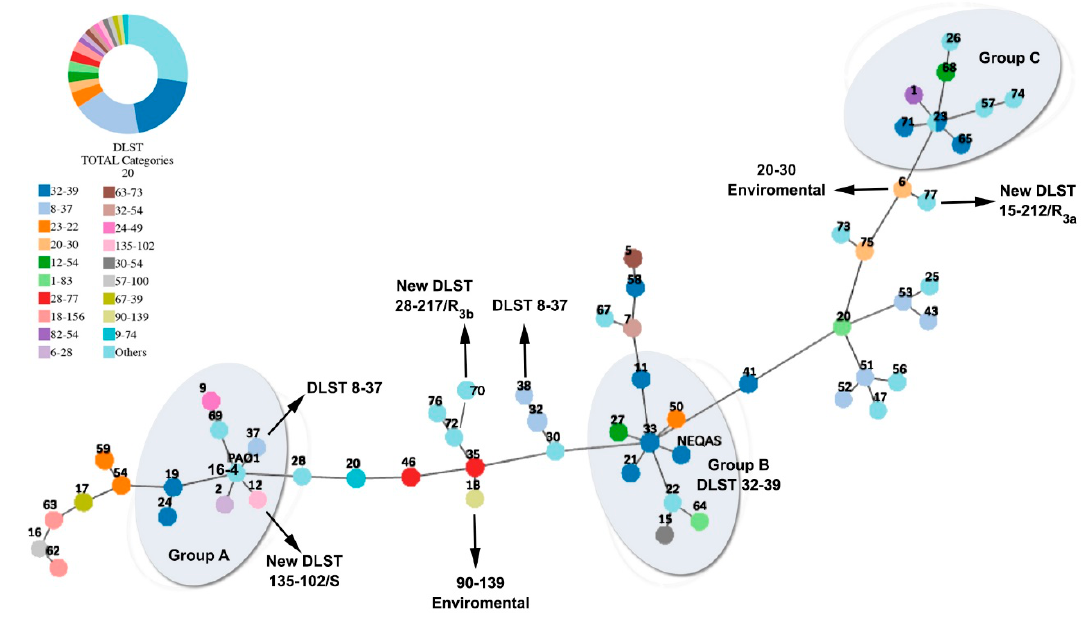
Figure 2. Minimum spanning tree resulting from e-burst analysis of P. aeruginosa isolates based on the DLST data. The 35 DLST-types are presented here, with the predominant and the new ones in bold.